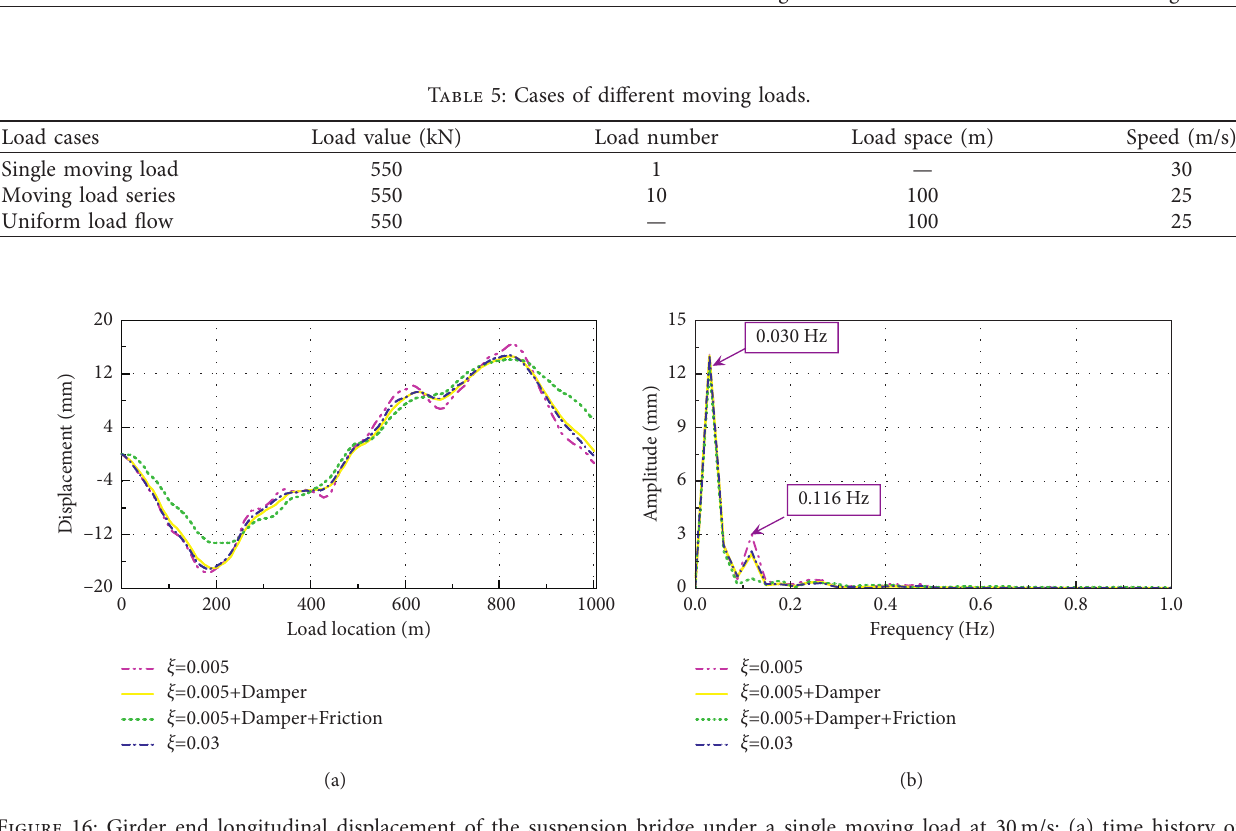
Figure 16: Girder end longitudinal displacement of the suspension bridge under a single moving load at 30 m/s: (a) time history of longitudinal displacement; (b) Fourier spectrum of longitudinal